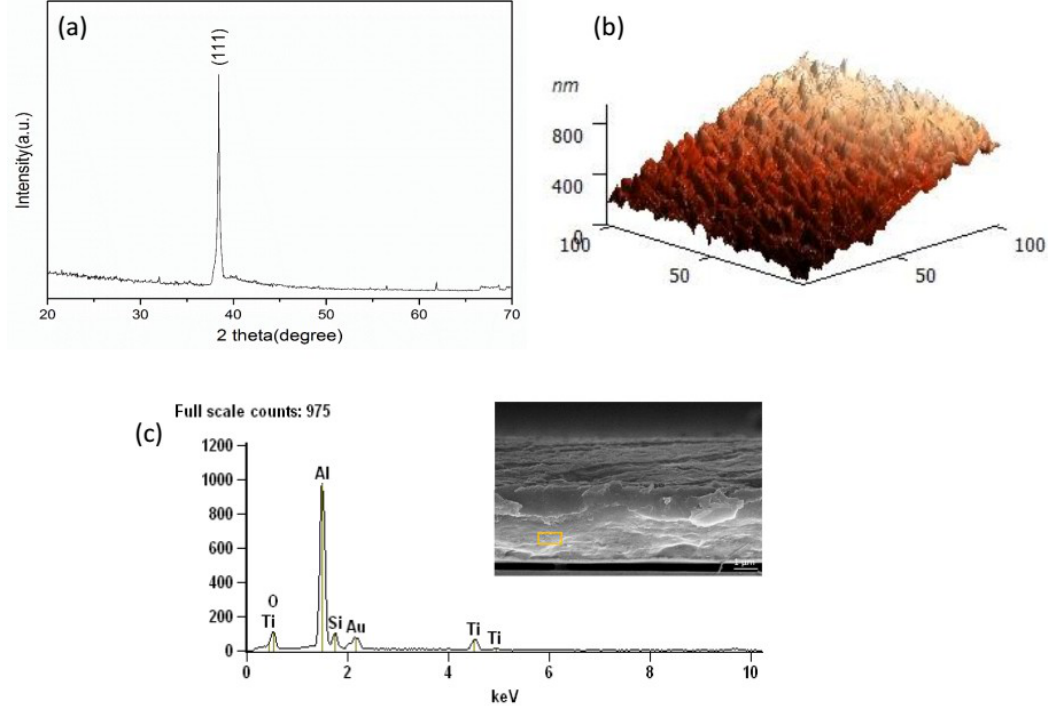
Figure 3. X‐ray diffraction (XRD), atomic force microscope (AFM) and energy dispersive X‐ray Figure 3. X-ray di ff raction (XRD), atomic force microscope (AFM) and energy dispersive X-ray spectroscopy (EDS) patterns of the silicon‐based Al/Ti film: ( a ) XRD; ( b ) AFM; ( c ) EDS. spectroscopy (EDS) patterns of the silicon-based Al / Ti film: ( a ) XRD; ( b ) AFM; ( c )